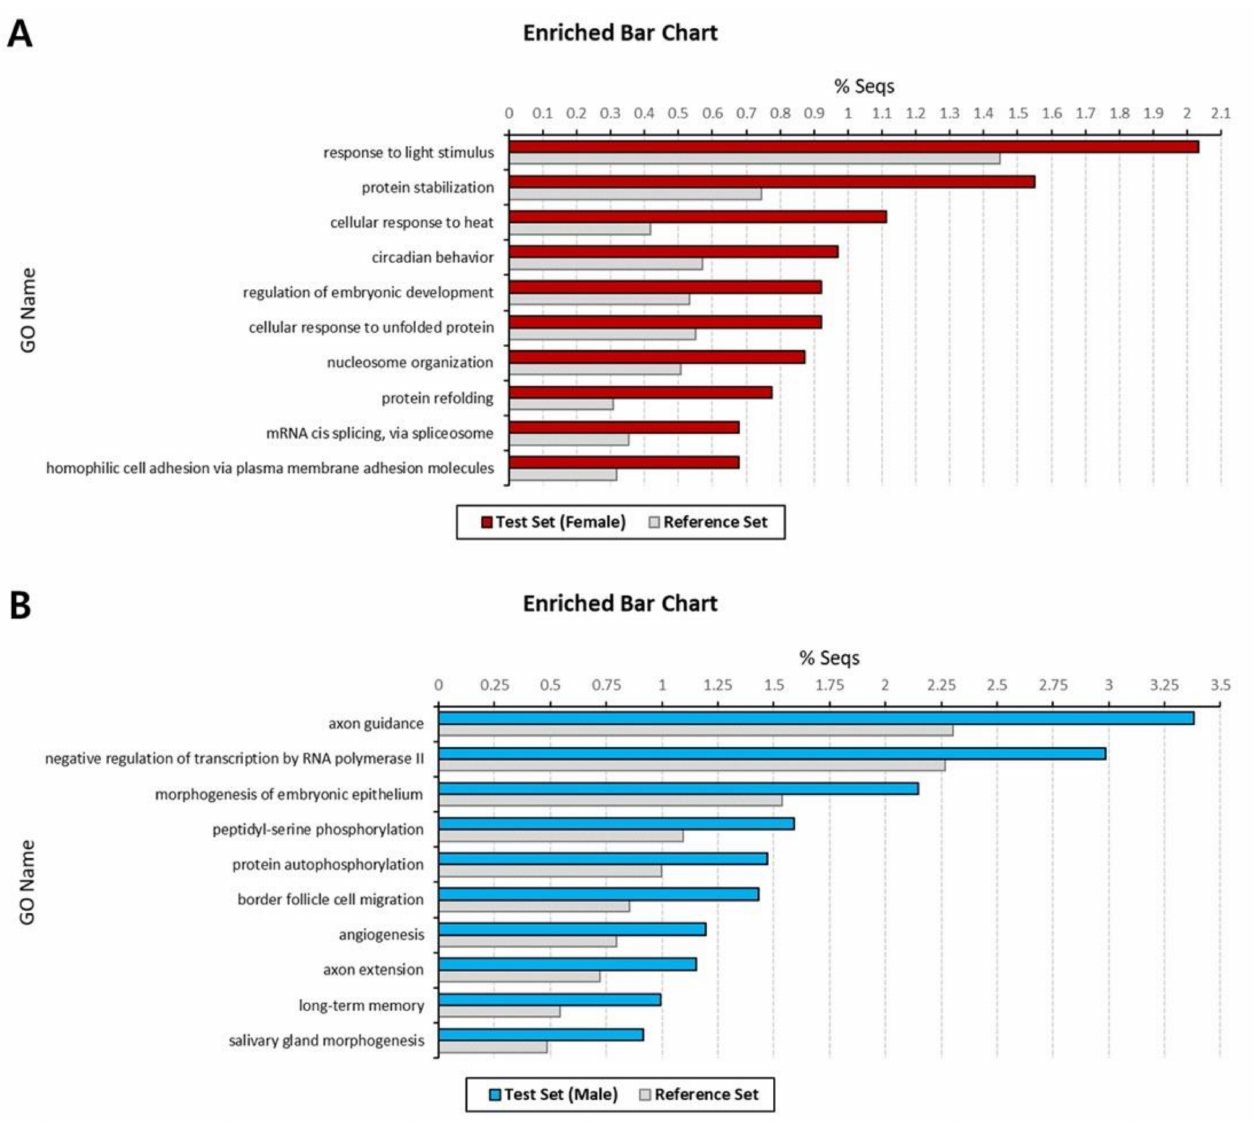
Figure 3. Top 10 enriched Gene Ontology (GO) terms of sex-specific transcripts in Artemia franciscana transcriptome. Enrichment analysis was performed for female-specific transcripts ( A ) and male-specific transcripts ( B ). Biological process GO terms that exhibit statistically significant differences are shown in the figure (Fisher’s exact test, p < 0.05). The X-axis represents the relative frequencies, and the Y-axis represents significant enriched GO